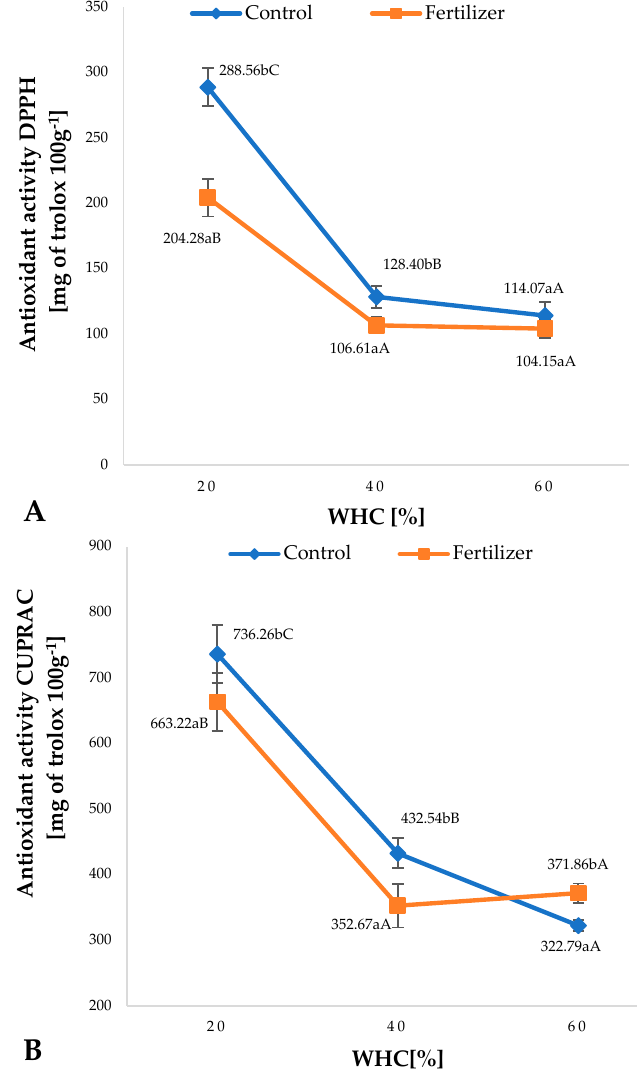
Figure 4. Antioxidant activity DPPH (2,2-difenylo-1-pikrylohydrazyl) test ( A ) and CUPRAC (cupric reducing antioxidant capacity) test ( B ) in maize leaves in relation to whether fertilizer was applied and to WHC [%] ( n = 20). Significant differences between the results for enhanced and non-enhanced plants growing in soils with the specific water holding capacity are marked with small letters according to the t -Test ( p < 0.05). Significant differences in the results for the various water holding capacity values are marked with capital letters according to the Tukey’s test ( p < 0.05).